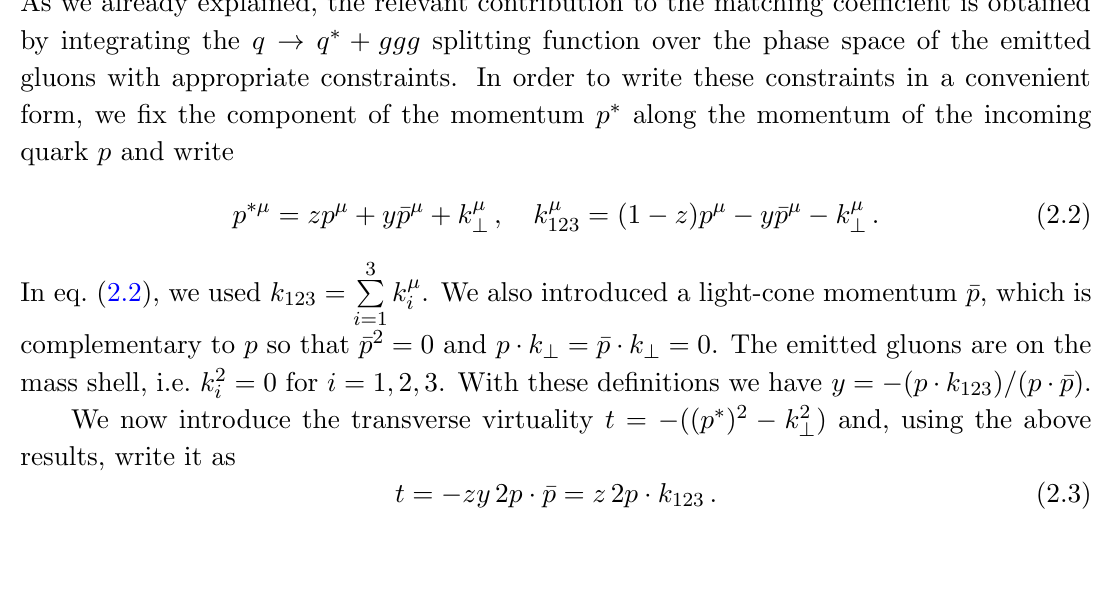
q (cid:3) + ggg and the process q i i !